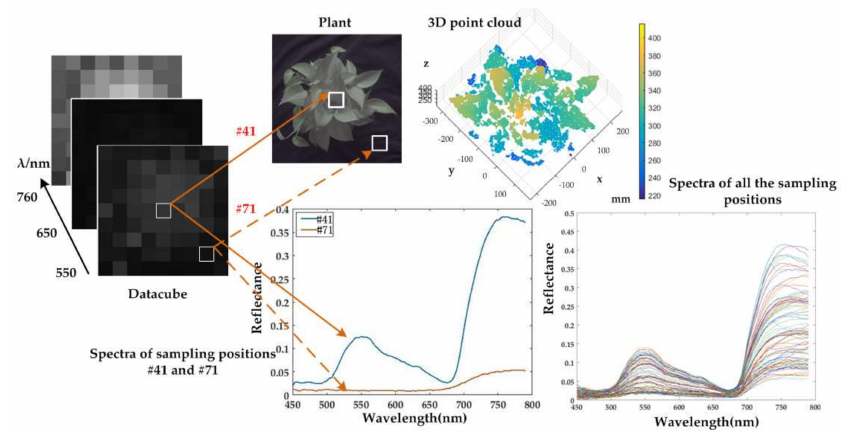
Figure 14. 3D and spectral data of Plant 1. The top panel shows the image and 3D point cloud of the plant, whereas the bottom panel denotes the spectral curves. The left panel shows the datacube, of which the spectral images at the wavelength of 550, 650, and 760 nm are